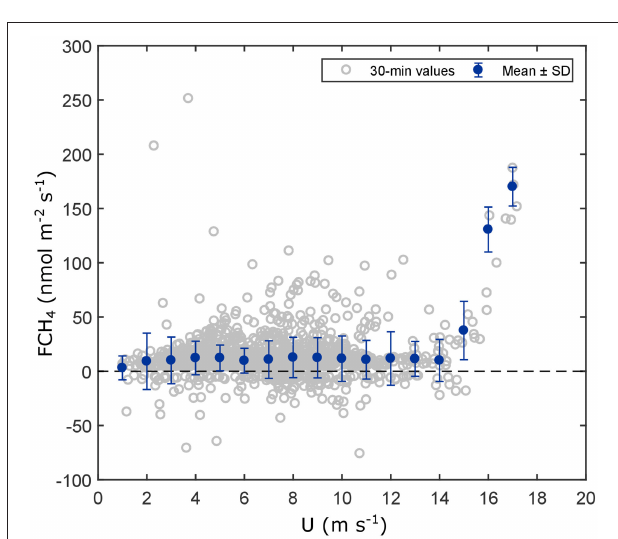
FIGURE 8 | Half-hourly FCH 4 values plotted as a function of the wind speed,